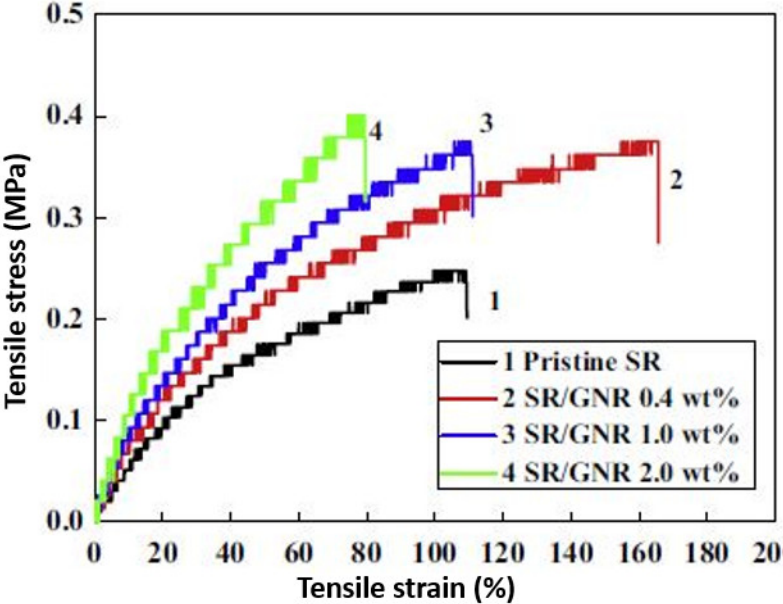
Figure 16. Typical stress-strain behaviors of the pristine silicone rubber (SR) and the SR/graphene nanoribbon (GNR) nanocomposites. Reproduced with permission from [135], Copyright Elsevier, 2015.